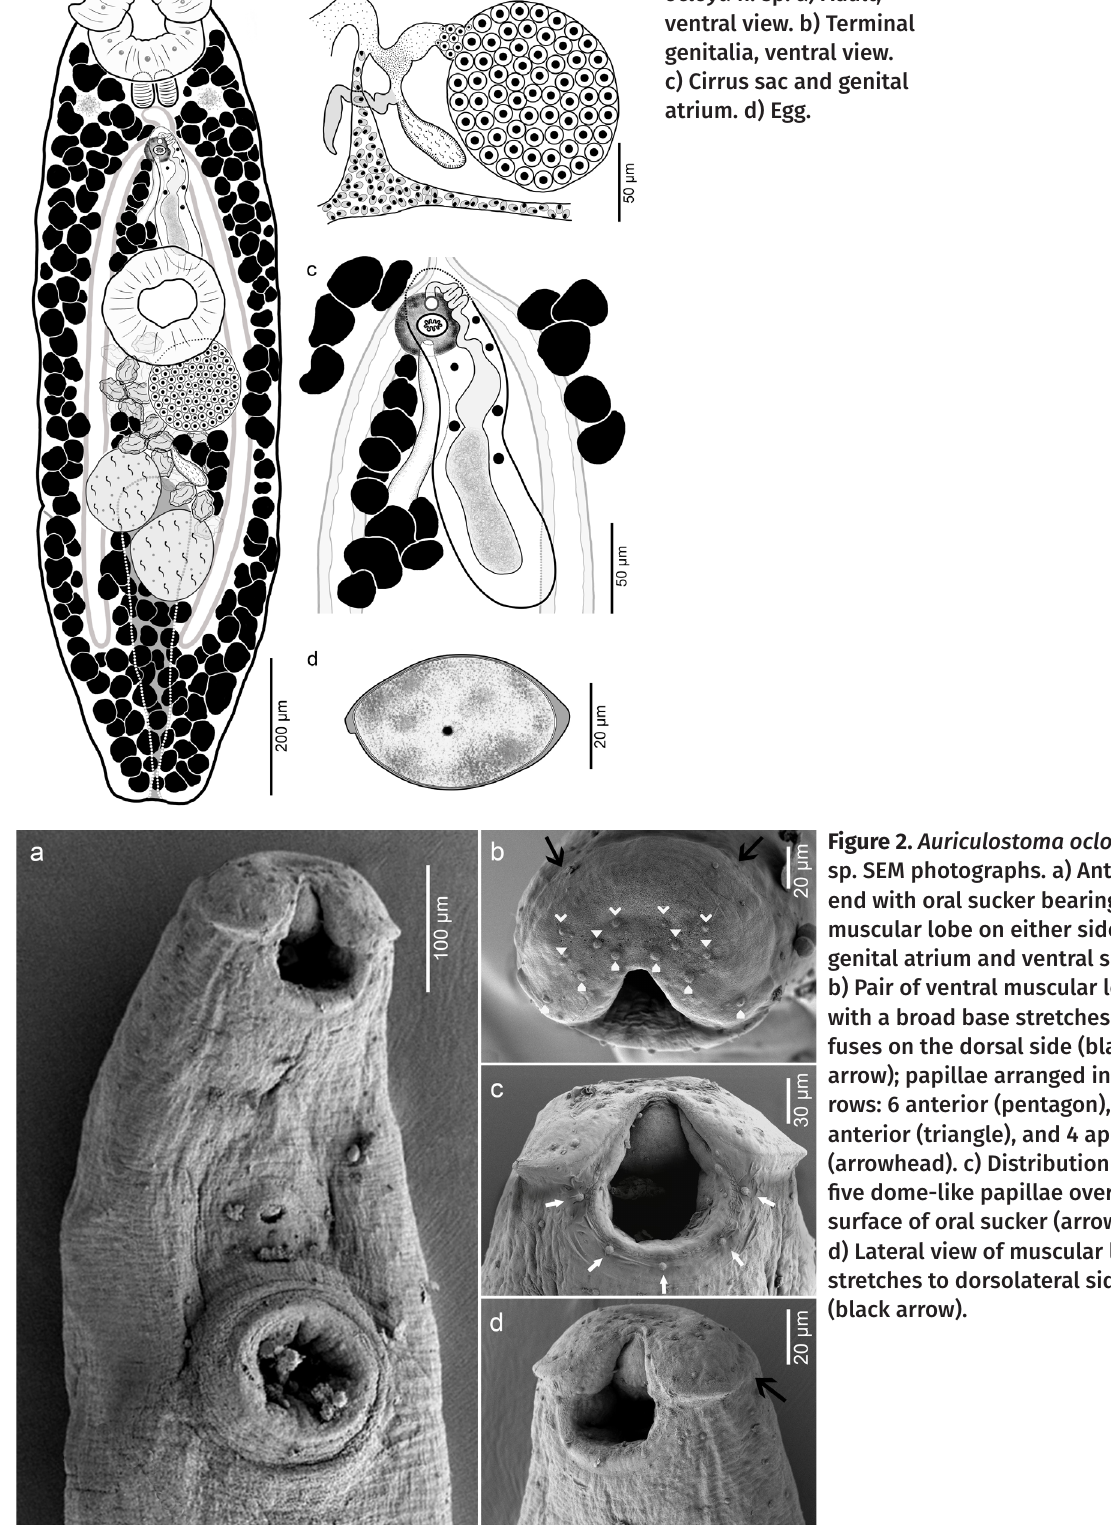
Figure 1. Auriculostoma ocloya n. sp. a) Adult, ventral view. b) Terminal